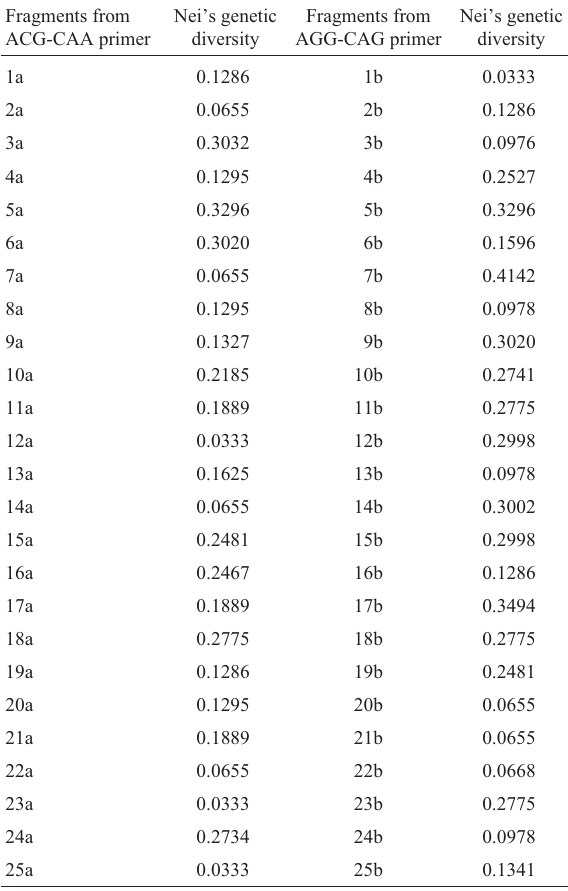
Table 1 - Nei’s genetic diversity values for the total Litopenaeus vannamei sample (n = 16 for broodstock line 03CMF1; n = 14 for line 03CBF1) and the overall sample mean (n = 30) and the overall mean considering both sets of primers. Fragments from Nei’s genetic ACG-CAA primer